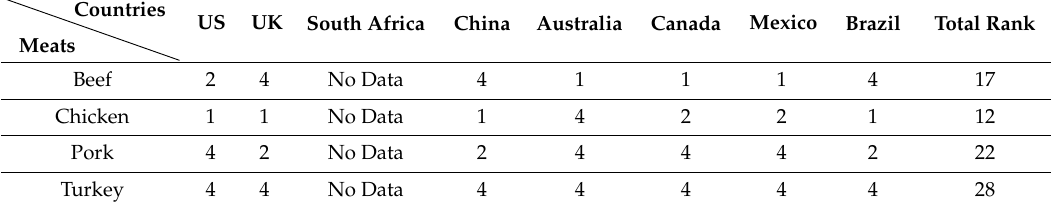
Figure 5. Hierarchical clusters of meat carriers are displayed for the US. Table 5. Ranking of beef, chicken, pork, and turkey based on their prevalence in each country. The ranking is on a scale of 1 to 4, 1 represents the most prevalent carrier while 4 represents the least prevalent carrier.